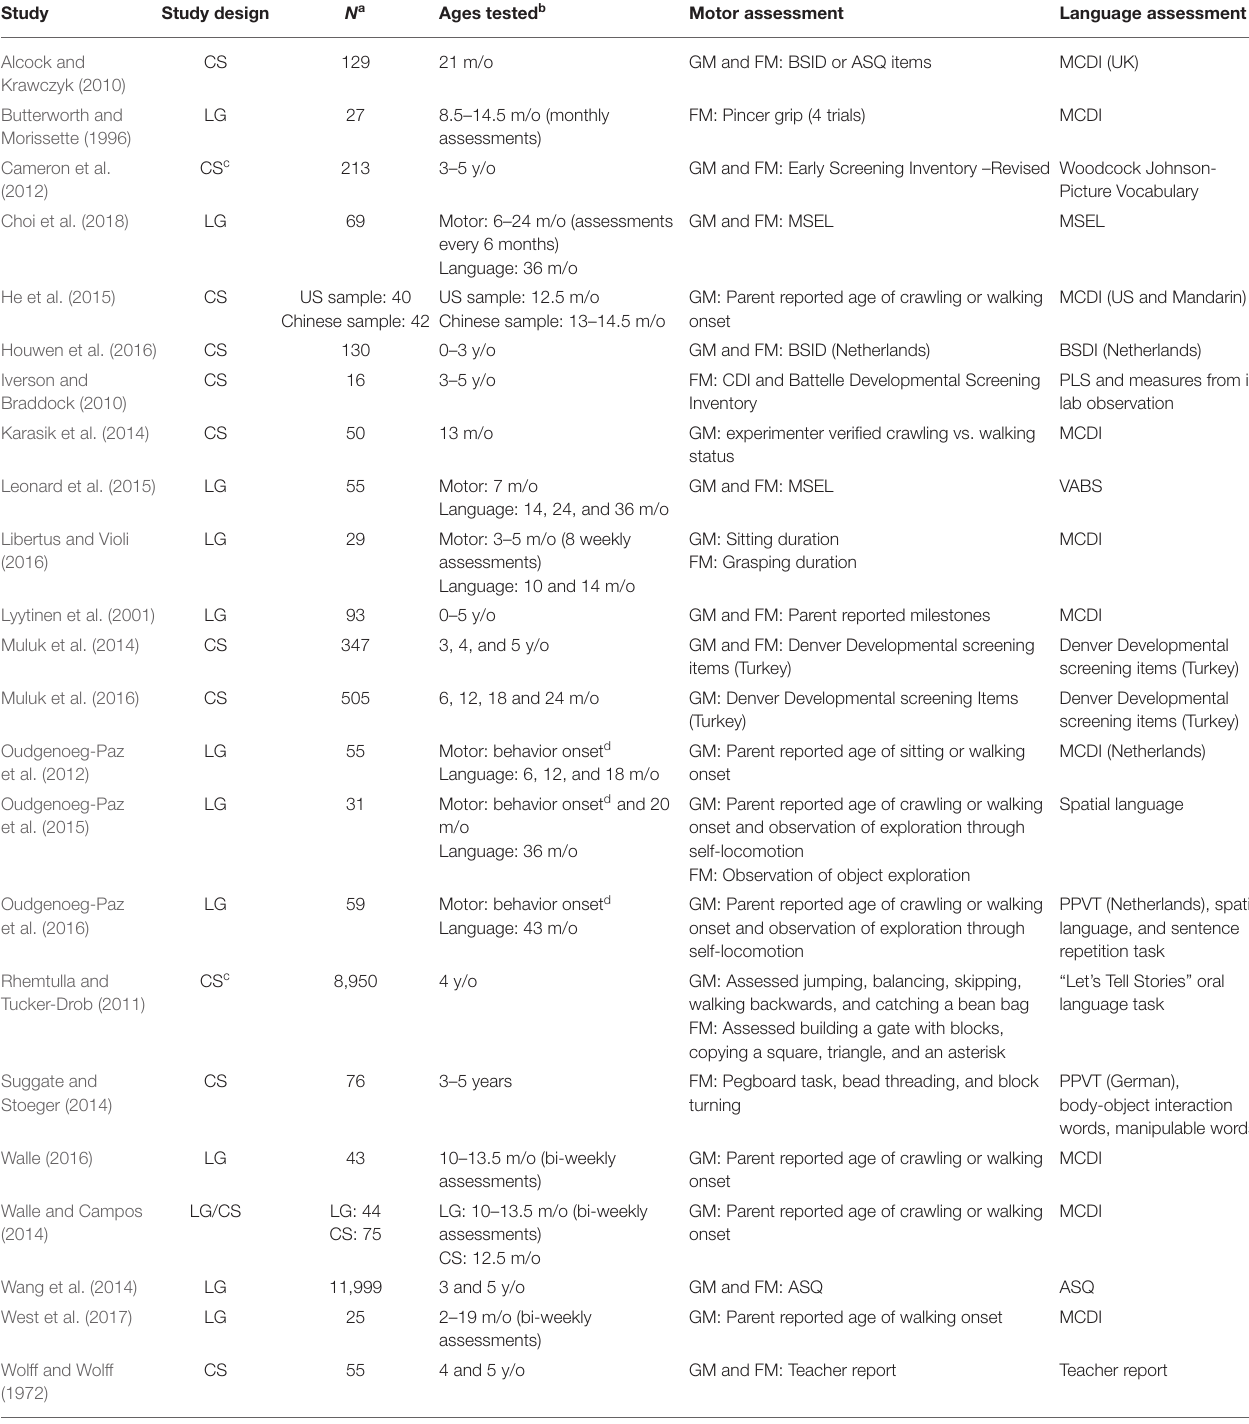
TABLE 1 | Articles included in systematic